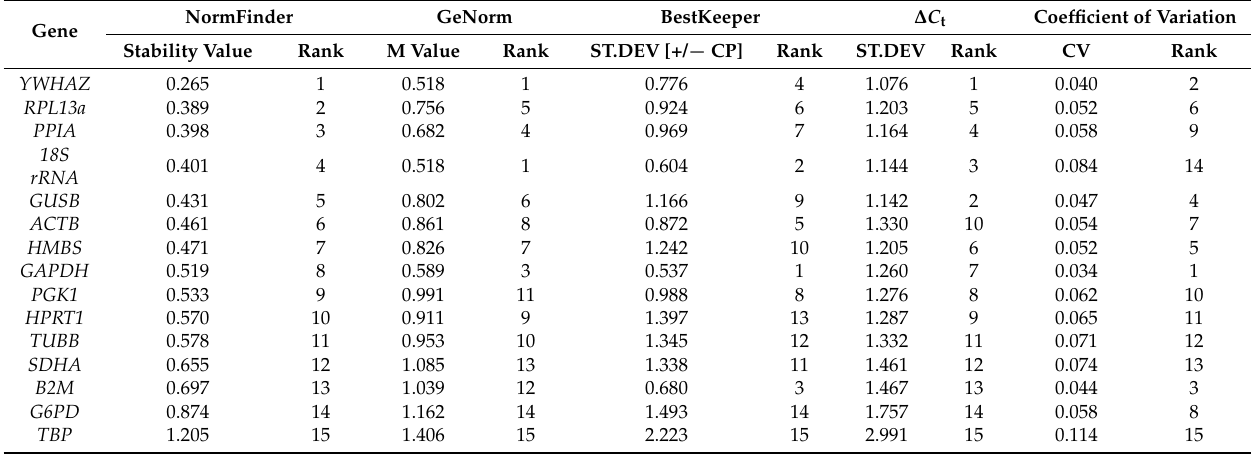
Table 3. Ranking of the expression of candidate HKG under acid pH culture conditions (pH 6.5).